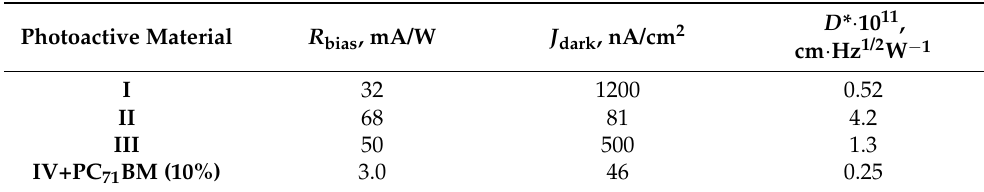
Table 3. Maximum responsivity, the lowest dark current density, and specific detectivity under bias V = − 0.1